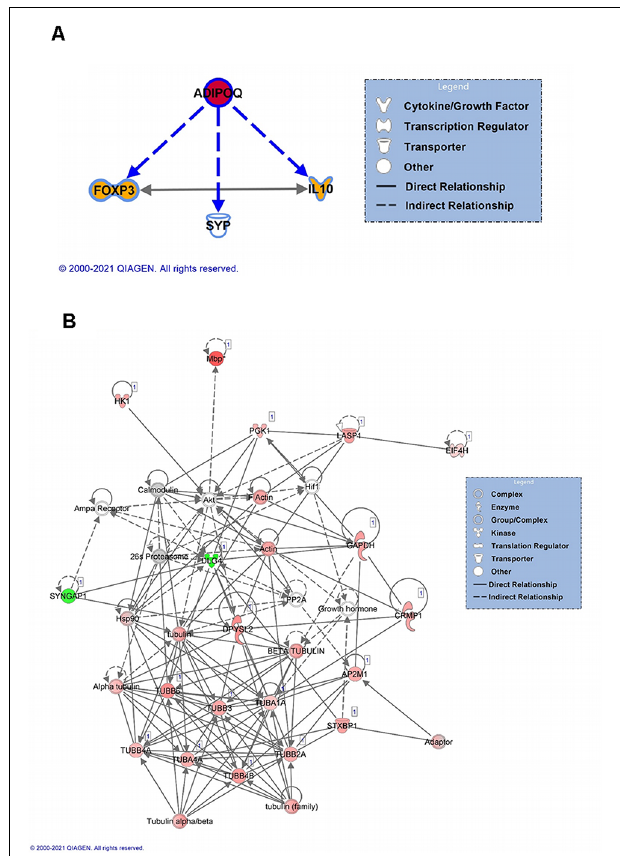
FIGURE 4 | Network analysis of linear polyubiquitin protein targets in the amygdala of male and female rats following fear conditioning. IPA analysis was performed on samples that underwent mass spectrometry analysis, as described in Figure 2 . (A) IPA analyses of downstream targets of Adiponectin protein with increased ubiquitination in females. The color red indicates an increase in the ubiquitination levels of Adiponectin, and the color orange indicates an activation of the target proteins. (B) Functional network of protein-protein interaction by IPA analysis in males. Using IPA, a protein network of proteins differentially ubiquitinated and other associated proteins was created. Solid lines refer to direct and dotted lines represent indirect directions between the proteins. The color red indicates increased ubiquitination, with shading denoting significance level, whereas the proteins with decreased ubiquitination levels are shown in green. Gray denotes proteins that are part of the network but not identified as targets of linear polyubiquitination in our LC/MS analysis. The protein-protein interactions are shown by arrows.